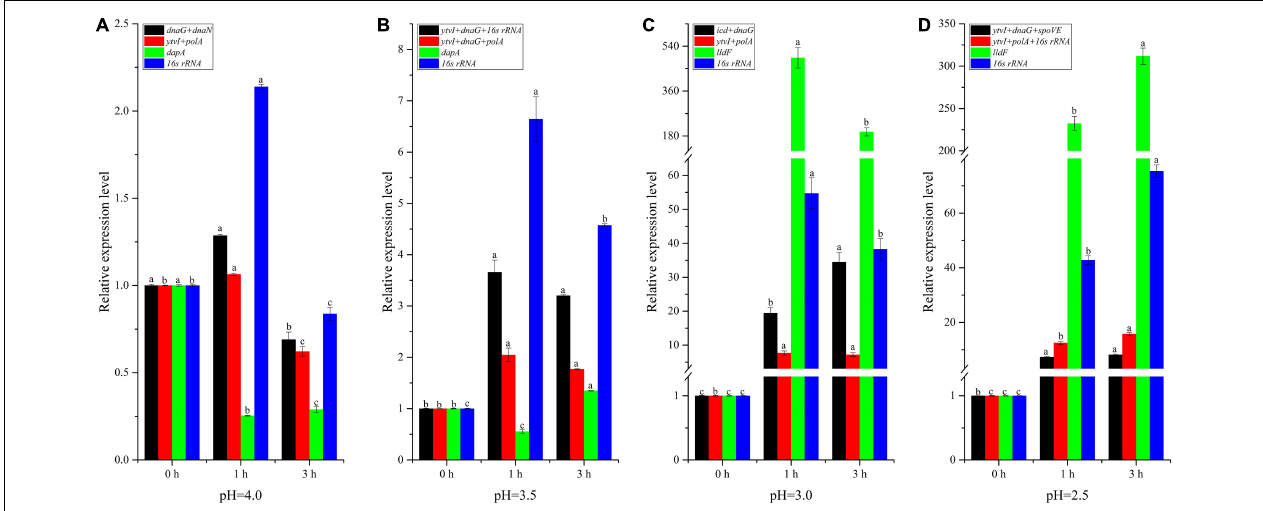
FIGURE 8 | Relative expression level of the ctsR gene normalized by the different reference genes (RGs) in A. acidoterrestris cells under different acid stress conditions. (A) pH = 4.0, (B) pH = 3.5, (C) pH = 3.0, (D) pH = 2.5. Different letters above each column for the same RG normalization strategy indicate significant differences at a significant level of